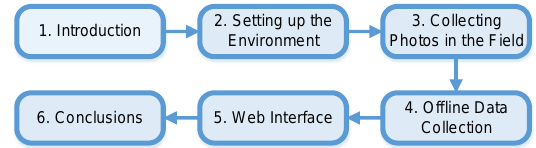
Figure 1. Overall view of the